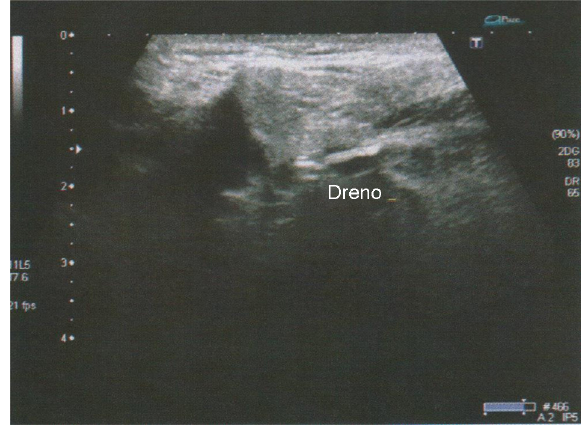
Figure 3 Ultrasound showing the catheter inside the salivary gland duct.